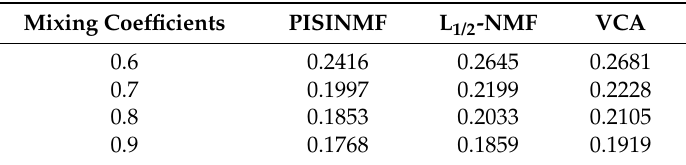
Table 6. RMSE comparison with different abundance mixing coefficients.